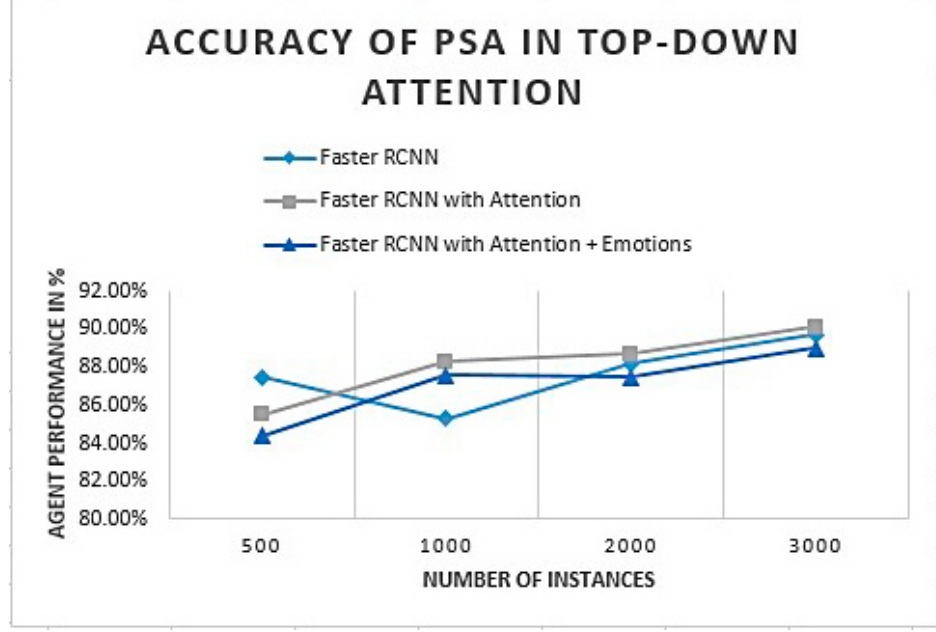
Figure 14. PSA performance given as a percentage in the top-down attention